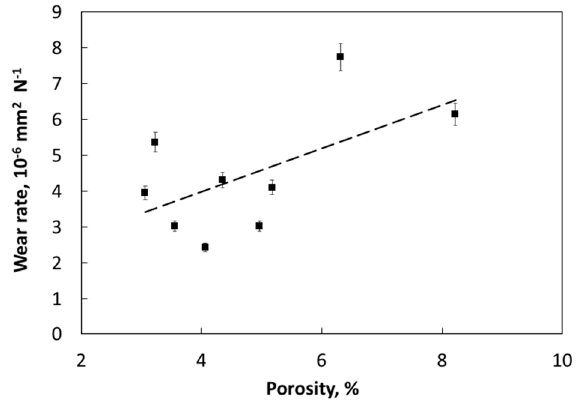
Figure 7. Results of the wear rate of the ball-on-disk test vs. the percentage of porosity, using an AISI